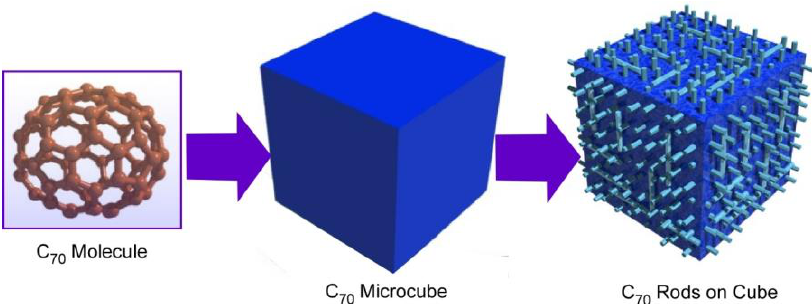
Figure 4. Hierarchic rods-on-cube structures of C 60 assembly fabricated through shape-shifting from micro-cube structures prepared with C 70 molecules.